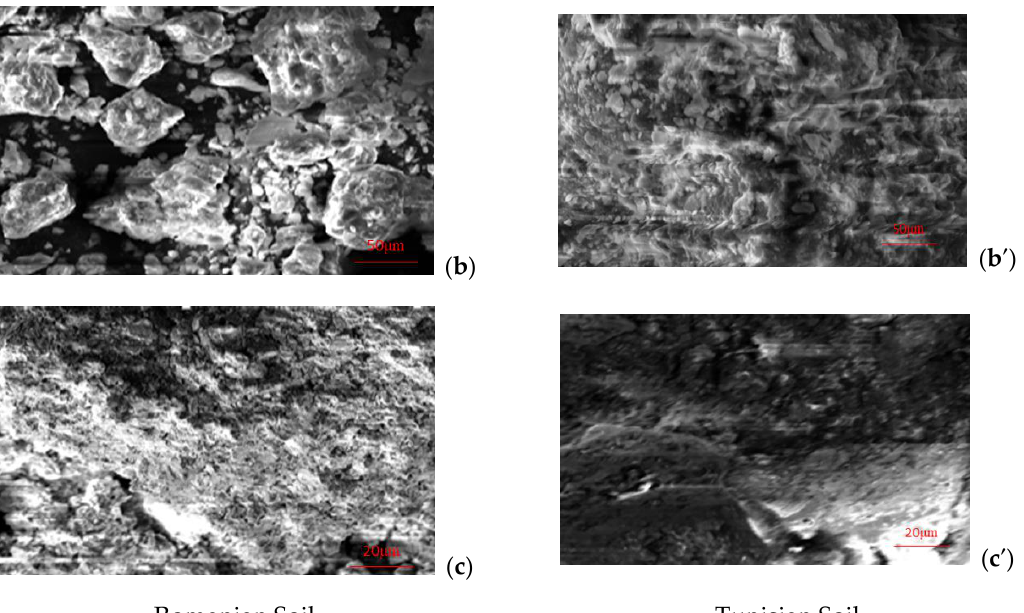
Figure 1. SEM image for Romanian and Tunisian soils: ( a ) resolution 10 0 μm ; ( a ′ ) resolution 200 μm ; ( b ) and ( b ′ ) resolution 5 0 μm ; ( c ) and ( c ′ ) resolution 2 0 μm .